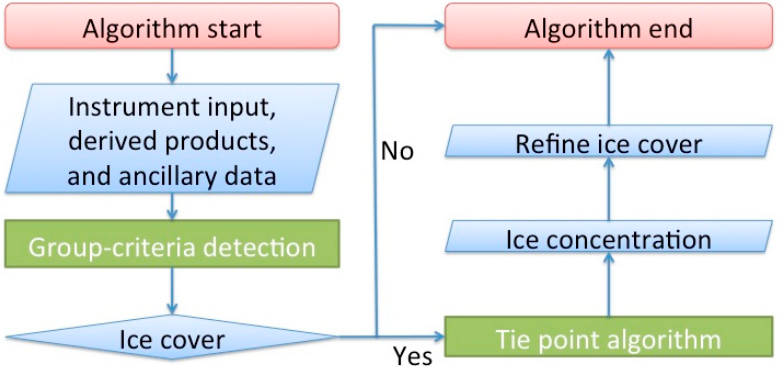
Figure 1. High level processing flow diagram of the ice cover mask and concentration algorithm.